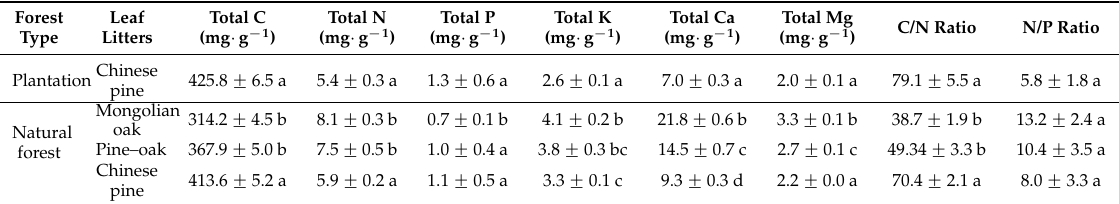
Table 3. Initial chemical composition of single-species litter and litter mixture in the plantation and natural forests of Chinese pine (Mean ˘ SE, n =